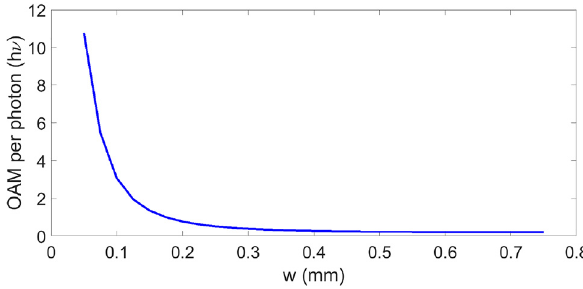
Figure 3: Average longitudinal OAM per photon gained by a 4 f cylindrical lens pair for input STOVs with different spatial